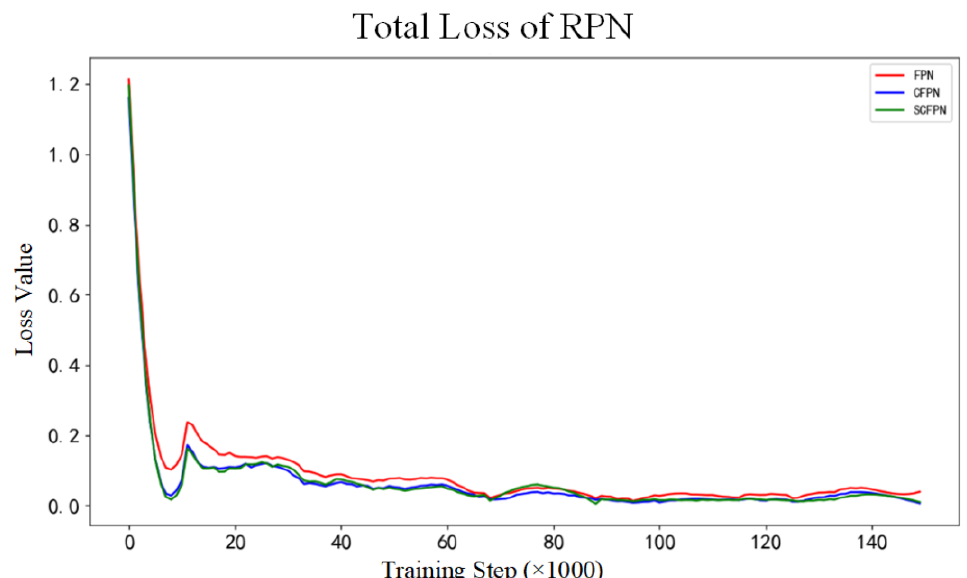
Figure 7. Total loss of RPN. Red: FPN; blue: CFPN; green: SCFPN.